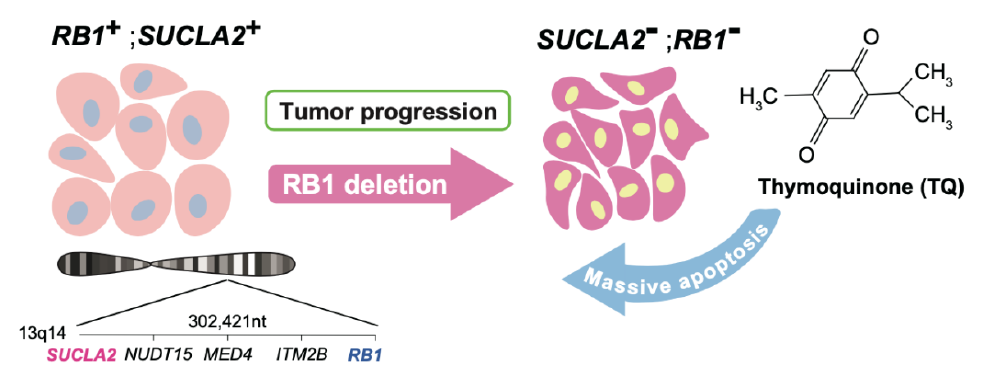
Figure 1. Thymoquinone targets SUCLA2 loss that collaterally takes place with RB1 homozygous or heterozygous deletion.